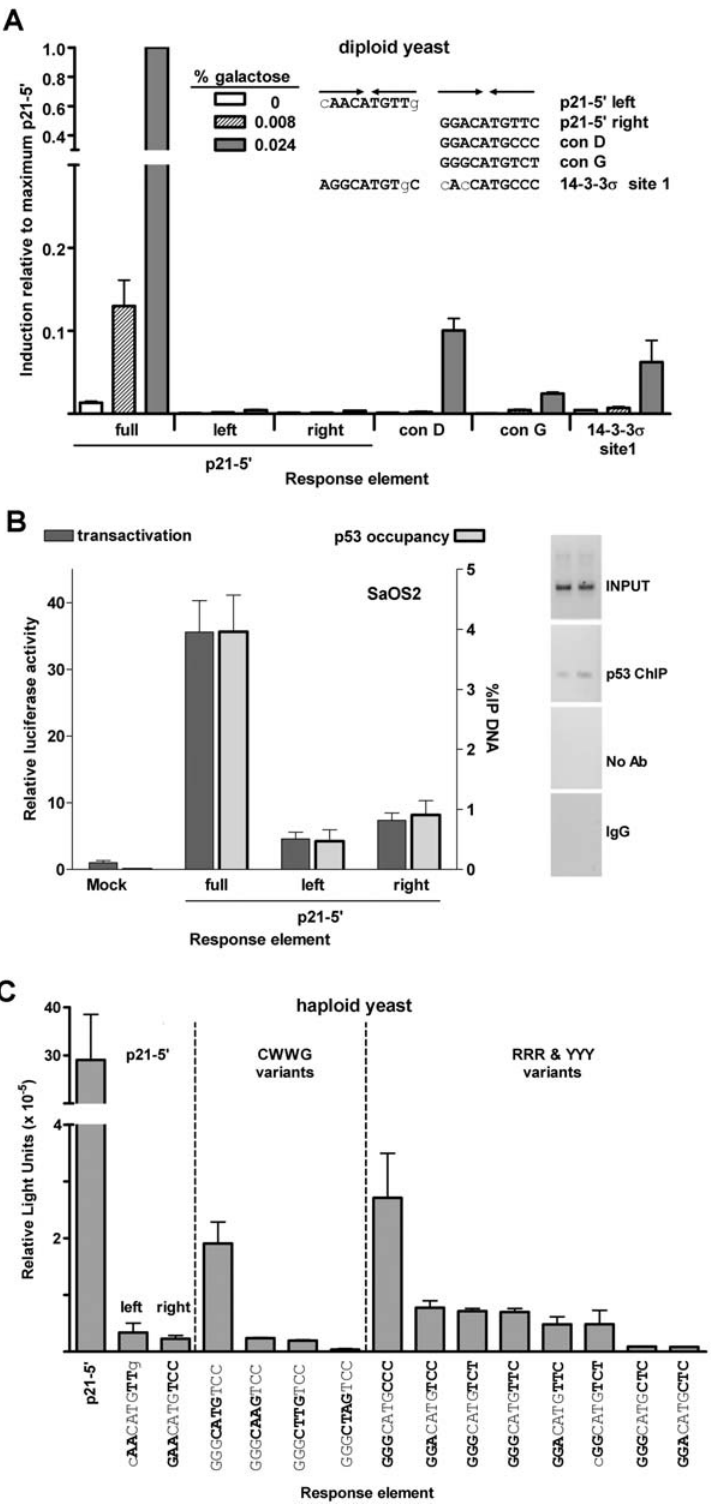
Figure 4. Half-sites function as noncanonical REs for transactivation in a sequence-dependent manner in yeast and human cells. (A) Transactivation from decamer REs in the diploid yeast was quantified with a luciferase assay. Protein lysates were obtained 24 hours post inoculation into galactose supplemented media. The average light units/ m g protein for WT p53 towards p21-5 9 at 0.024% galactose for six biological repeats was 1.8 million. Solid arrows indicate J -binding sites. Comparisons were made with transactivation from the p21-5 9 full site at high protein levels. (B) Transactivation in human SaOS2 cells. The cells were co-transfected with WT p53 along with either the full, left or right half-sites of the p21-5 9 RE containing reporter construct. Transactivation was assessed with the luciferase assay 48 hours later. Relative luciferase activity was compared to a mock transfection containing the promoter-less pGL3 plasmid. Presented are the averages and standard deviations of 3 independent experiments